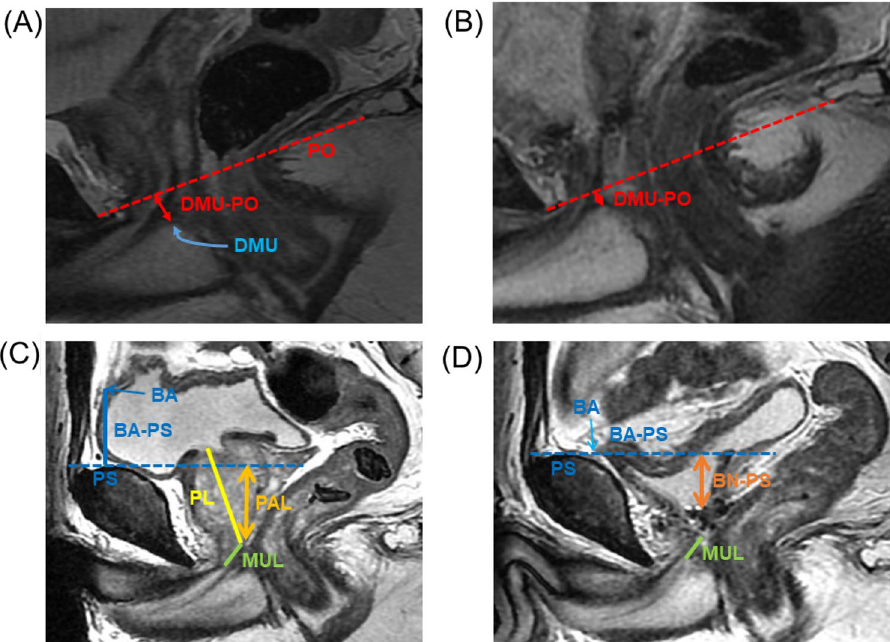
Figure 1. Parameters on mid-sagittal magnetic resonance imaging before ( A , C ) and 10 days after ( B , D ) robot- assisted radical prostatectomy. ( A , B ) The pelvic outlet (PO) (dashed red line) is defined as the line between the lowest end of the pubic bone and the tip of the coccyx. DMU-PO (red bidirectional arrowheads) is the distance from the distal end of the membranous urethra (DMU) to the midline of the PO. ( C , D ) Bladder attachment (BA) is defined as the upper edge of the attachment between the anterior bladder wall and abdominal wall. Pubic symphysis (PS) is defined as the upper edge of the PS. BA-PS (blue line) is the distance from the BA to the PS. Prostate length (PL) (yellow line). PS-to-prostate apex length (PAL) (orange bidirectional arrowheads) is defined as the distance between the extension lines of the suprapubic ridge line (dashed blue line) and the prostate apically. Membranous urethral length (MUL) (green line). Bladder neck to PS (BN-PS) (brown bidirectional arrowheads) is defined as the distance between the extension lines of the suprapubic ridge line and the lowest end of the bladder